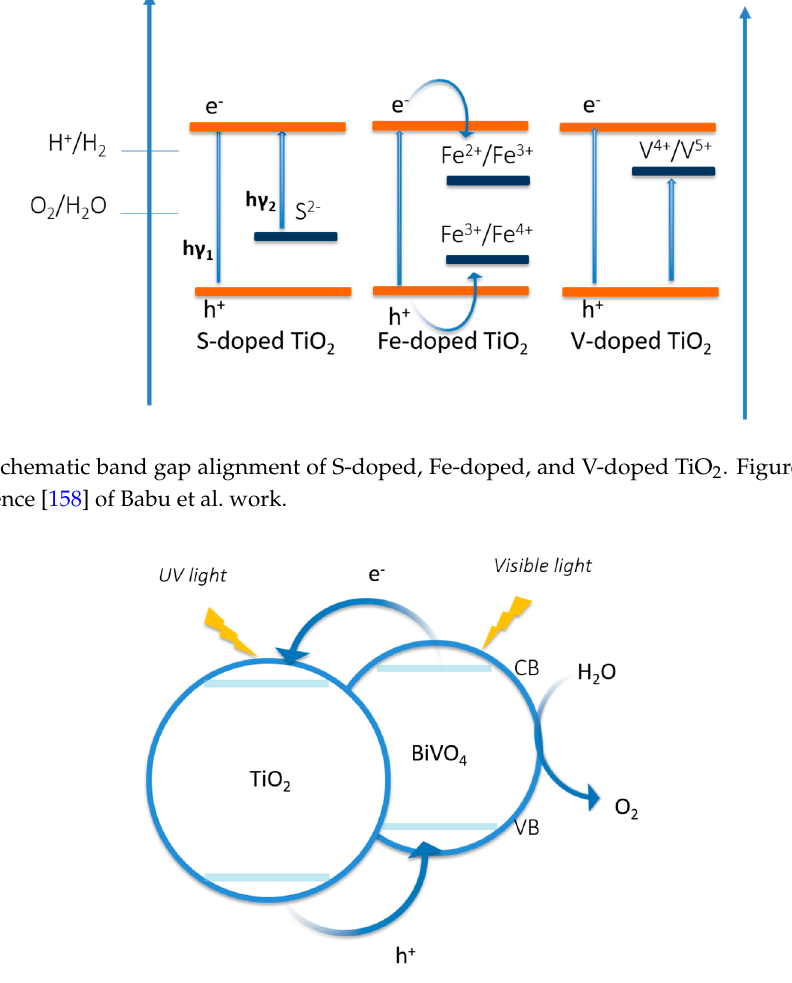
Figure 6. Schematic band gap alignment of TiO 2 /BiVO 4 heterojunction. Figure adapted from references [4,161] of Moniz et al. and Resasco et al. works respectively.